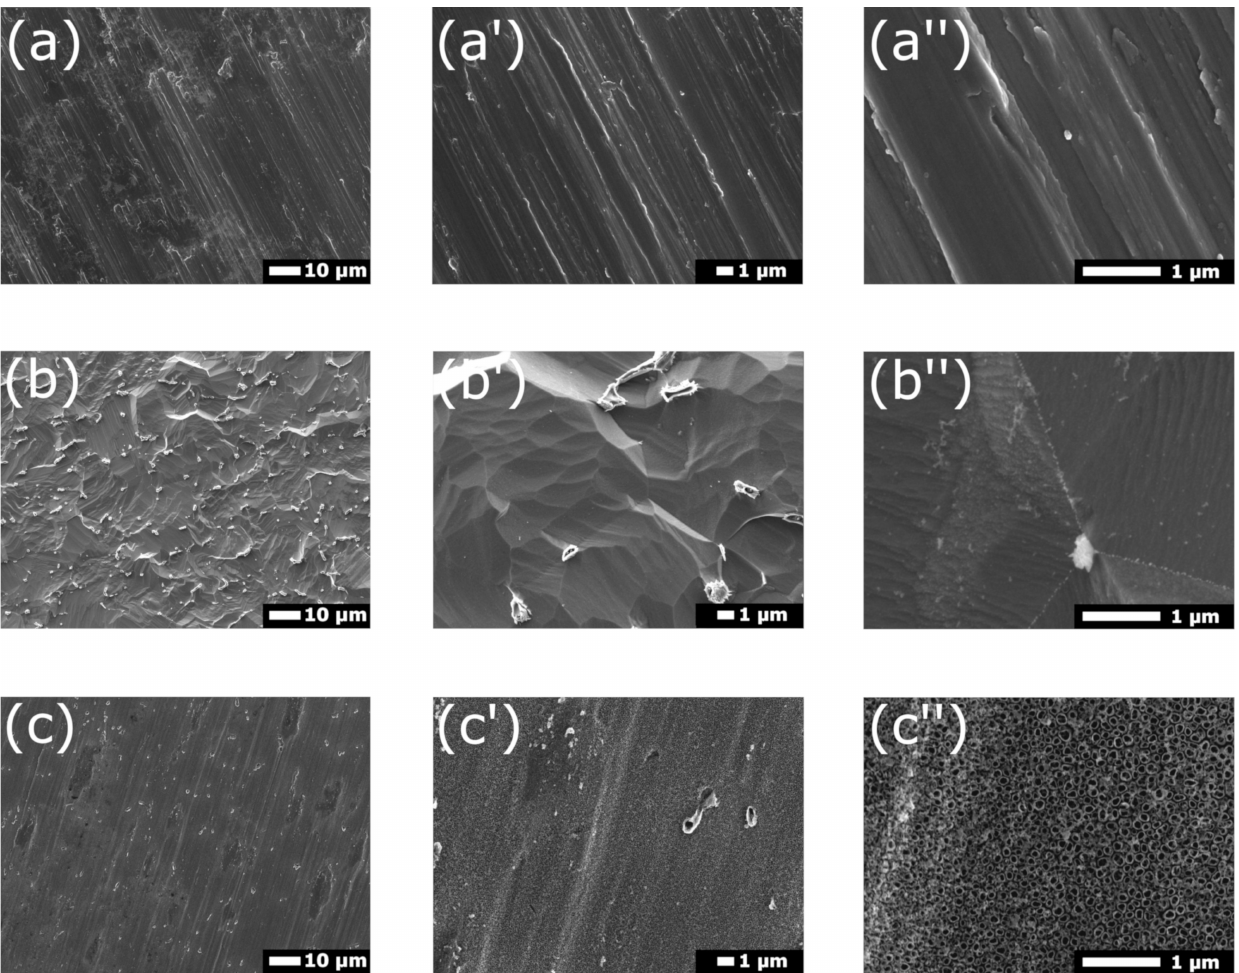
Figure 1. SEM images of surface pretreated Ti grade 2 substrates after ( a ) wet grinding, ( b ) acid etching, and ( c ) electro- chemical anodization in different magnifications: × 1000 (a–c), × 5000 (a’–c’), and × 25000